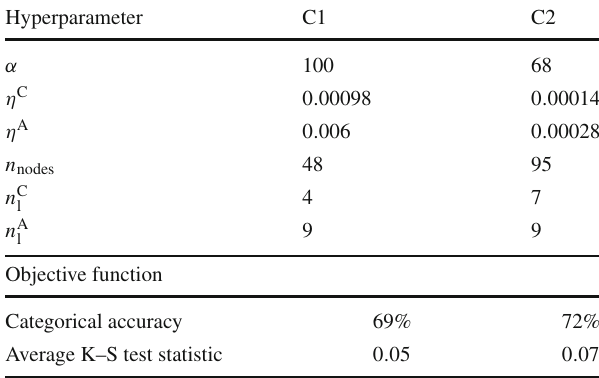
Table 3 Categorical accuracy, average K–S test statistic and hyperpa- rameters numerical values associated to the chosen working point